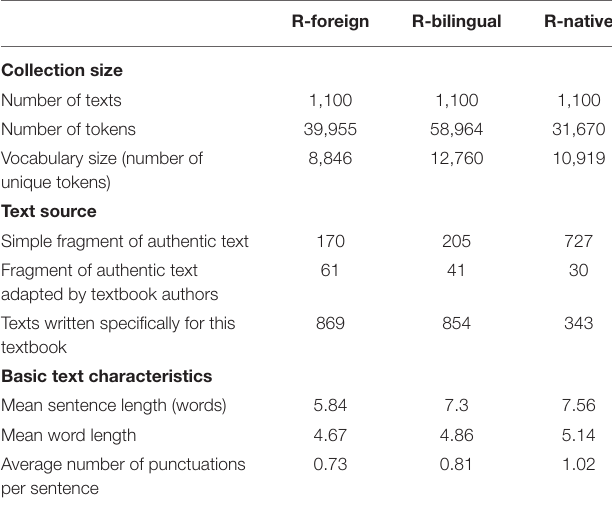
TABLE 1 | Characteristics of the three subdomain of texts randomly chosen from the TIRTEC corpus for the following